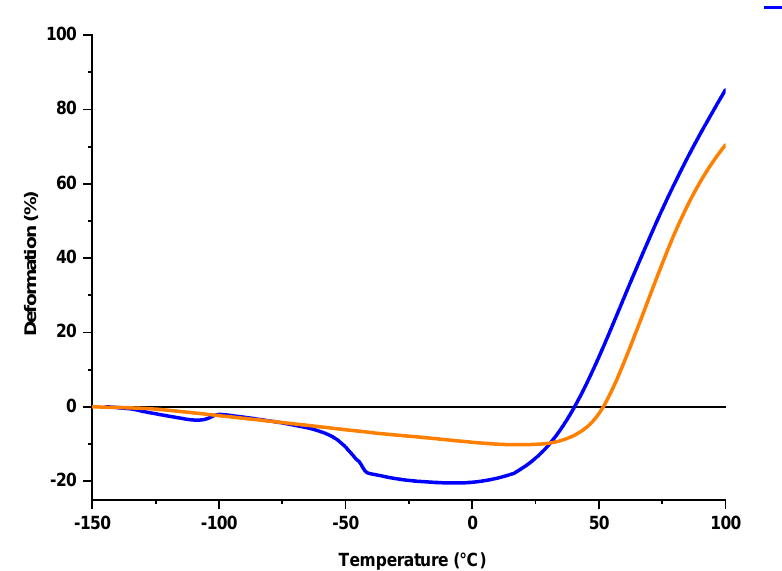
Figure 14. TMA curves for polymers 3 a,b at a heating rate of 5 °C/min in dilatometric mode with a constant load of 0.01 N.